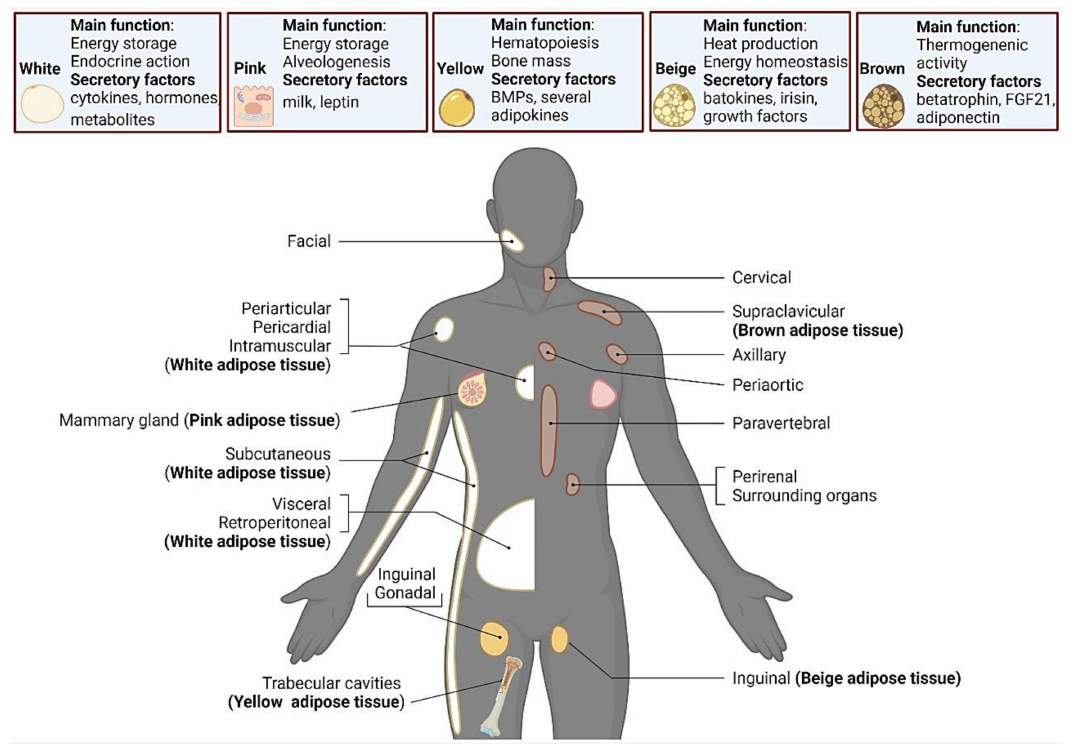
Figure 2. The distinct functions and localizations of white, pink, yellow, beige, and brown adipocytes. Biorender web-based software was used to create the figure (License Number